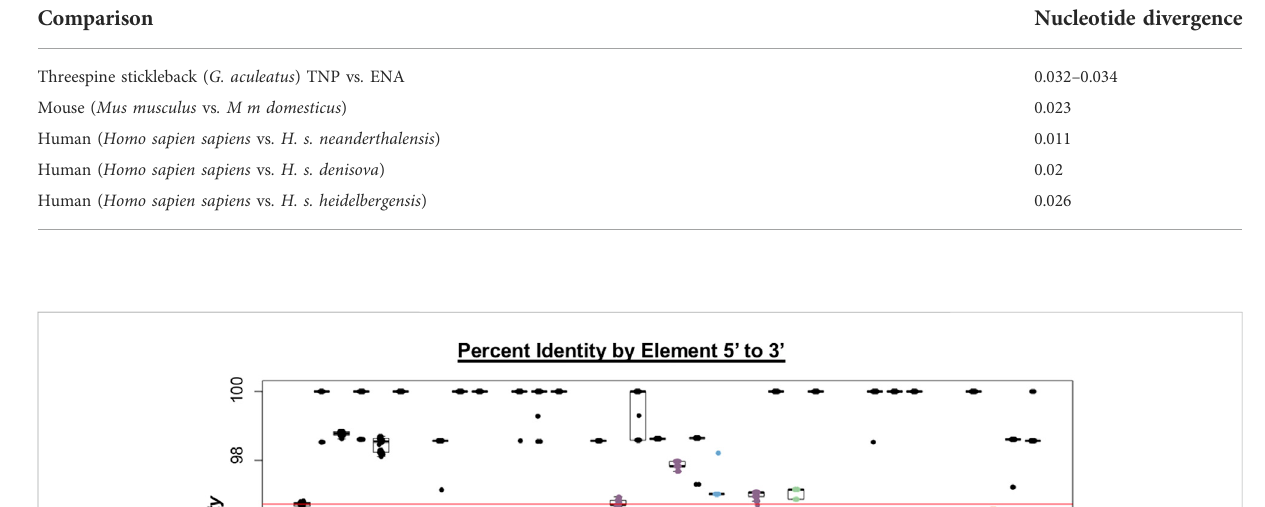
TABLE 1 Mitogenomic coding divergence in threespine stickleback ( Gasterosteus aculeatus ) compared to mammalian models for mitochondrial divergence. TNP indicates the Trans-North-Paci fi c mitotype and ENA indicates the Euro-North American mitotype.